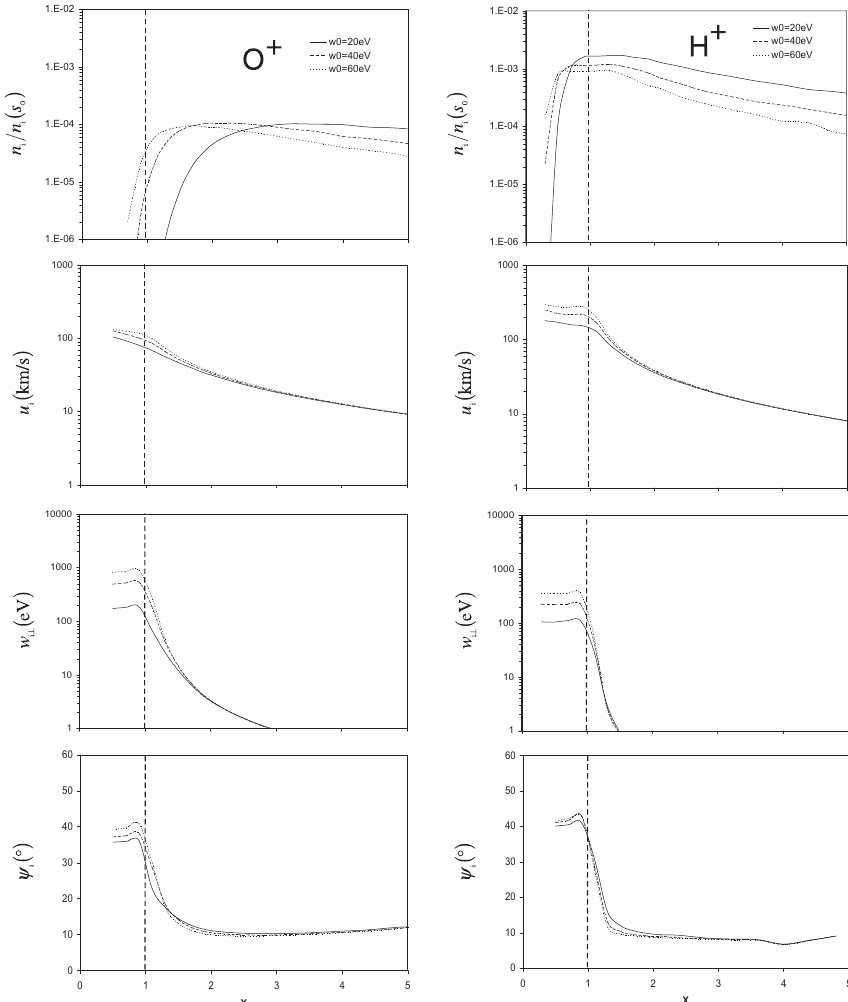
Fig. 11. Evolution of O + (left) and H + (right) moments along the poleward heating boundary. From top to bottom: density, upward mean velocity, perpendicular mean energy, and apex. The solid, dashed and dotted curves are associated with different values of the parameter w 0 as listed in the toper